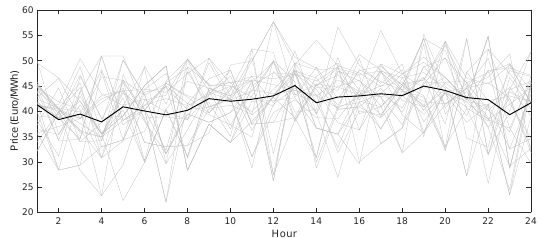
Figure 4. Scenarios and mean of the intra-day market selling prices.